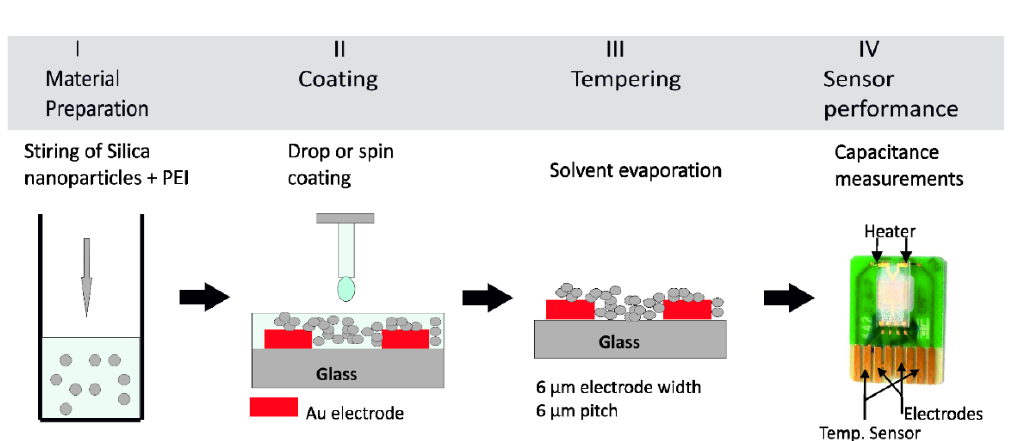
Figure 1. Scheme of the preparation of a capacitive CO 2 sensor in four steps. (Step I ) Magnetic stirring of the organic PEI and inorganic Silica nanoparticles. (Step II ) Spin coating or drop coating of the PEI@silica resulting suspension onto a clean interdigitated transducer on glass substrate. (Step III ) Tempering process at 120 °C for 15 min to ensure a complete solvent evaporate from the sensing layer. (Step VI ) Capacitive measurement of the prepared CO 2 sensor.